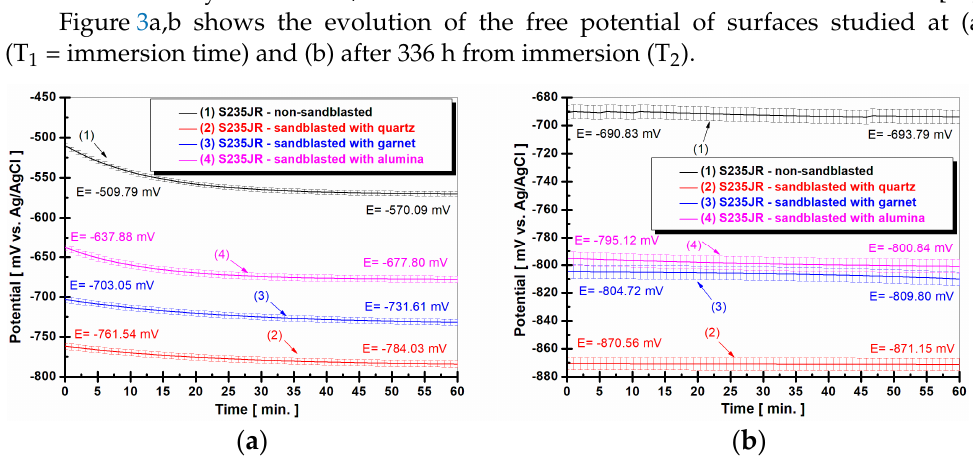
Figure 3. Evolution of free potential of S235JR steel samples immersed in 3.5% NaCl solution for (1) S235JR—non ‐ sandblasted, (2)—S235JR—sandblasted with quartz, (3)—S235JR—sandblasted with garnet, (4)—S235JR—sandblasted with alumina: ( a ) at T 1 = at immersion, ( b ) T 2 = after 336 h immersion time.